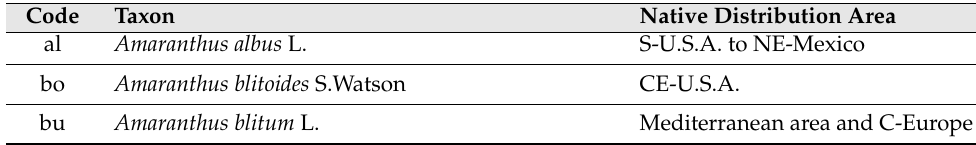
Table 1. List of the Amaranthus taxa studied (alphabetical order). Native distribution areas from [41] and, concerning A. blitum , from [3]. S: South; W: West; N: North: E: East; C: Central. Code